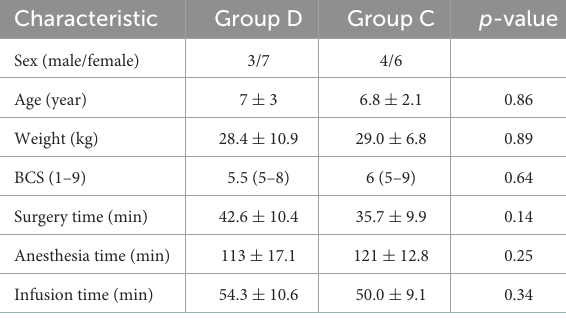
TABLE 1 Demographic data and surgery data.